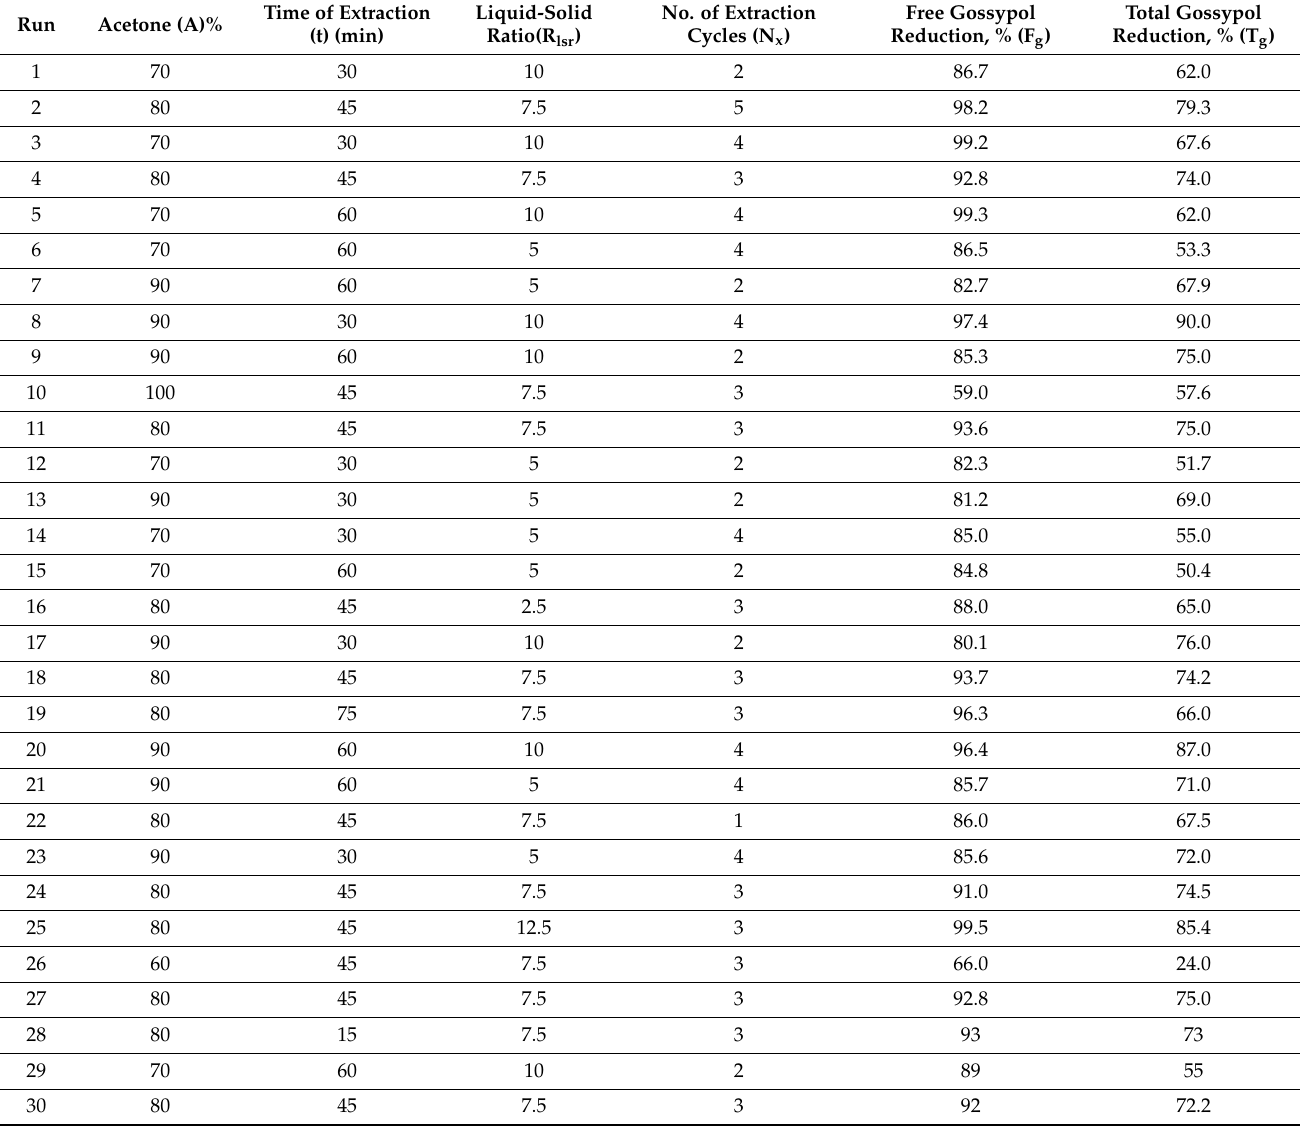
Table 2. Central Composite rotatable design for free gossypol and total gossypol reduction.